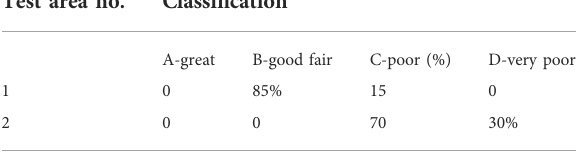
TABLE 6 Rock mass classi fi cation in the two areas after grouting. Test area